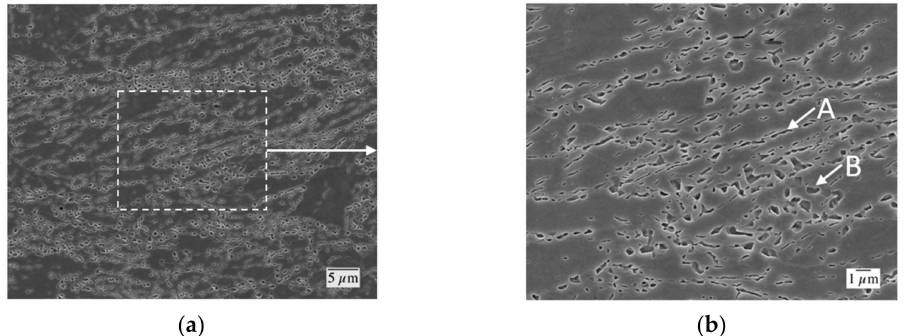
Figure 6. Field-emission scanning electron microscope (FESEM) images of the CR50 condition after heating to 650 ◦ C at 0.05 ◦ C / s followed by quenching to 30 ◦ C at 100 ◦ C / s. Higher magnification of the boxed region in ( a ) is shown in ( b ). Elongated regions of martensite (previously austenite) at deformed ferrite grain boundaries are labeled A. More equiaxed regions of martensite (previously austenite) are labeled B. One pct Nital